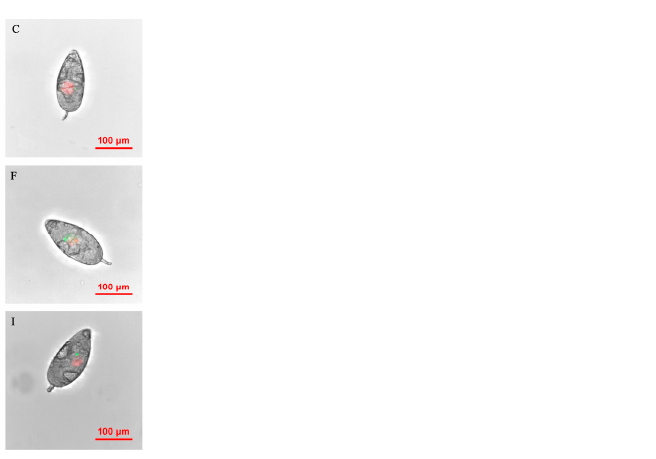
Figure 5. FISH visualization of Wolbachia and Rickettsia in egg stages (36–72 h) of B. tabaci. Localization of symbiotic bacteria Rickettsia (red) and Wolbachia (green) in the B. tabaci eggs at different times (( A – C ): 36 h, ( D – F ): 48 h, ( G – I ): 72 h). Rickettsia fluorescence ( A , D , G ) and Wolbachia fluorescence ( B , E , H ) are displayed in dark field; W olbachia and Rickettsia fluorescence ( C , F , I ) is displayed in bright field.